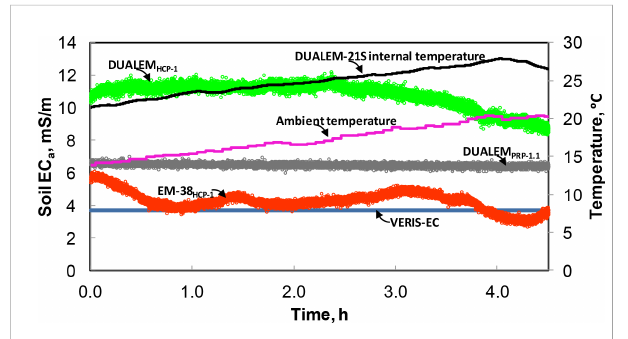
FIGURE 6 An example of 1-s soil EC a measurement logs obtained on 9-Oct.